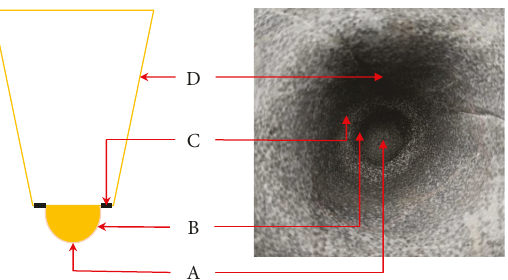
Figure 10: Position of scanning electron microscope. (A) Base of the hemispherical bottom. (B) The side of the hemispherical bottom. (C) Annular platform of the erosion pit. (D) The side of the erosion